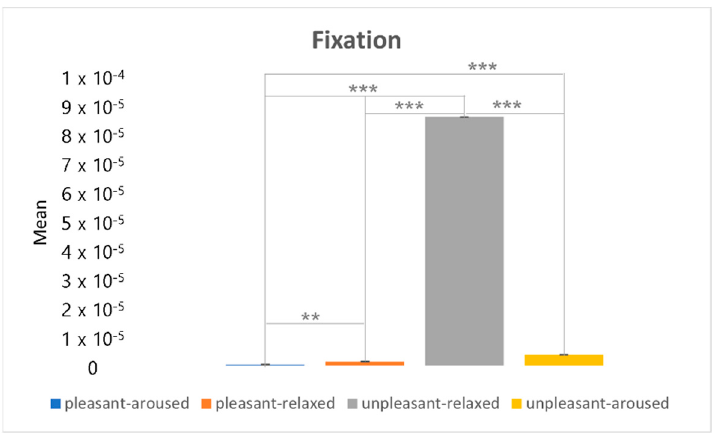
Figure 24. The post hoc analysis on the fixation. ** p < 0.05. *** p < 0.001.